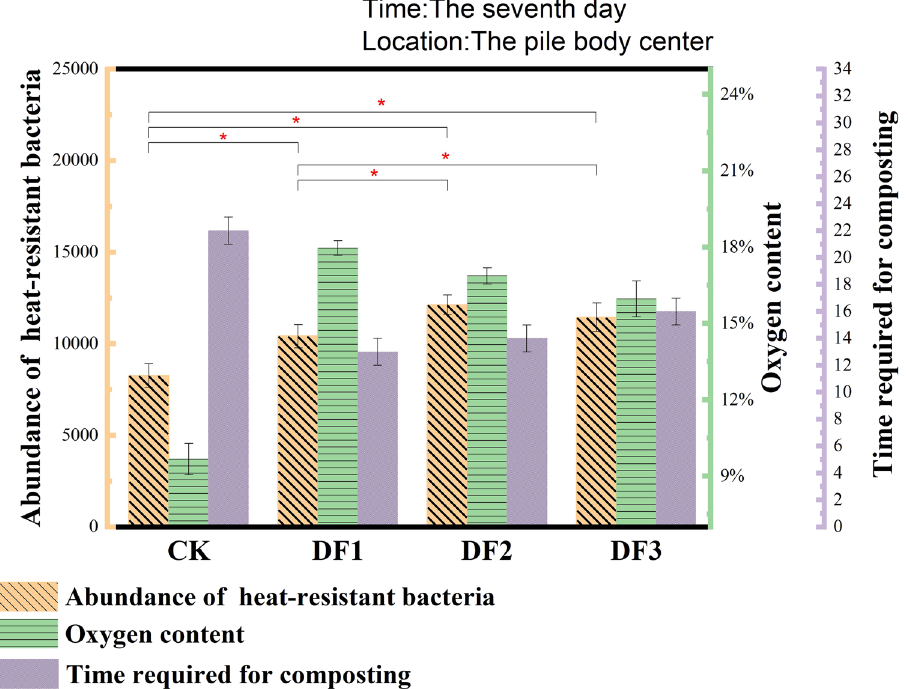
Figure 10. The abundance of thermophilic bacteria, oxygen content and the time required for composting; “*” means that p < 0.05 indicates a significant